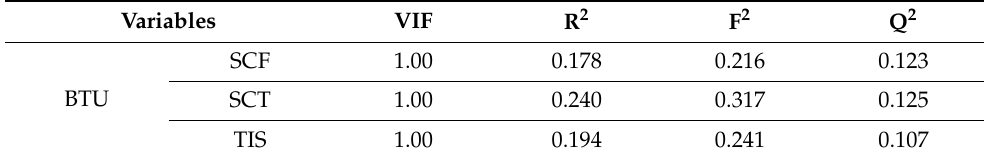
Table 6. Research model coefficients.